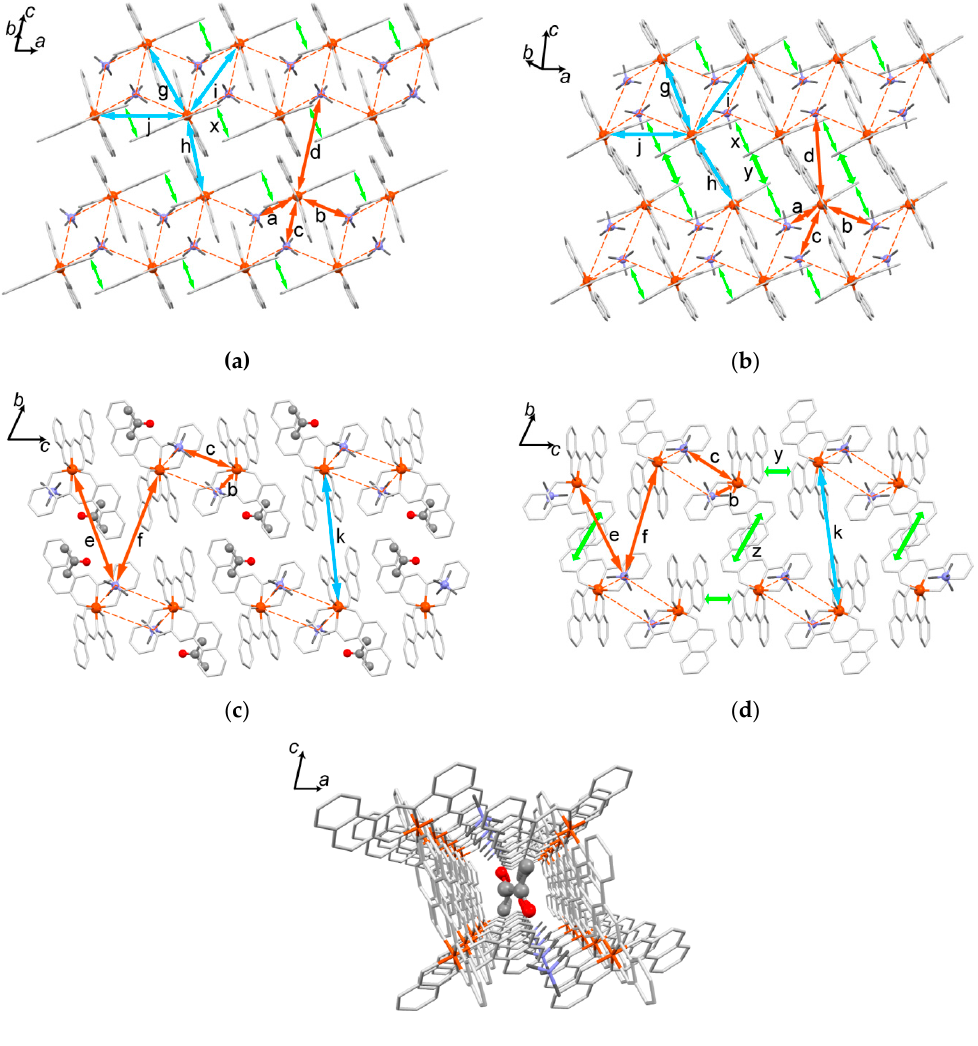
Figure 7. Crystal structures parallel to two-leg ladder-like cation···anion arrays for 2 ( a ) and 2’ ( b ). Acetone molecules are omitted for clarity; Crystal structures perpendicular to the two-leg ladder-like cation···anion arrays for 2 ( c ) and 2’ ( d ); ( e ) 1D channel structure along the b axis in 2 . Orange, cyan, and green double arrows indicate neighboring Fe···N, Fe···Fe distances, and π -stacking interactions, respectively. Orange dash lines indicate Fe···N distances shorter than 6 Å. The letters correspond to those in Table 4.